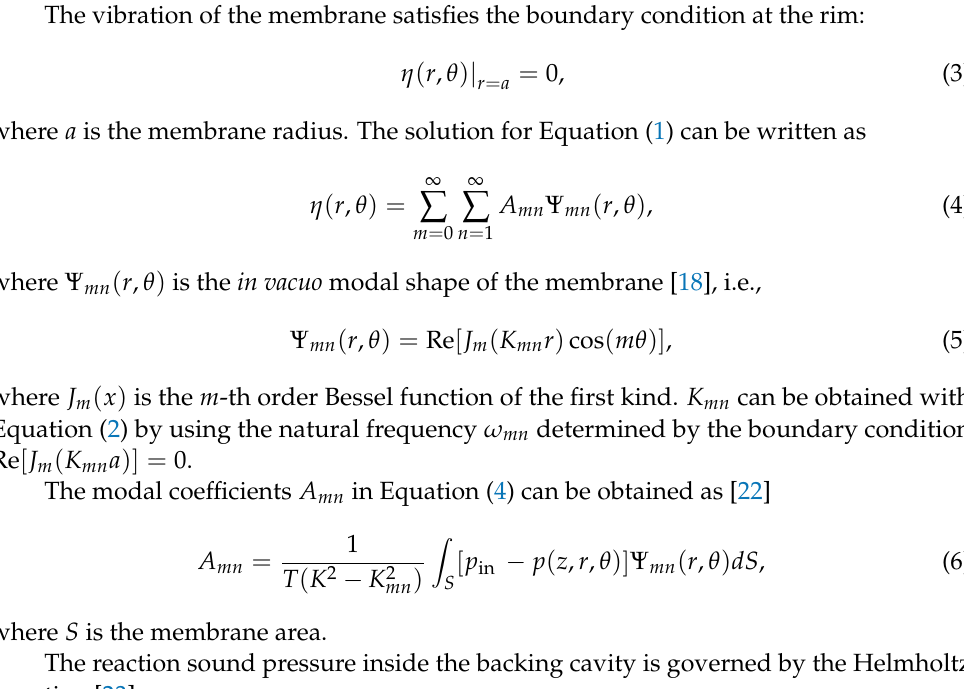
Figure 1. ( a ) Schematic diagram of the demonstrated remote acoustic sensing apparatus, where the LDV measures the acoustically induced vibration of the membrane at the point of testing. ( b ) Cross section of the membrane with a backing cavity. ( c ) Isometric view of the